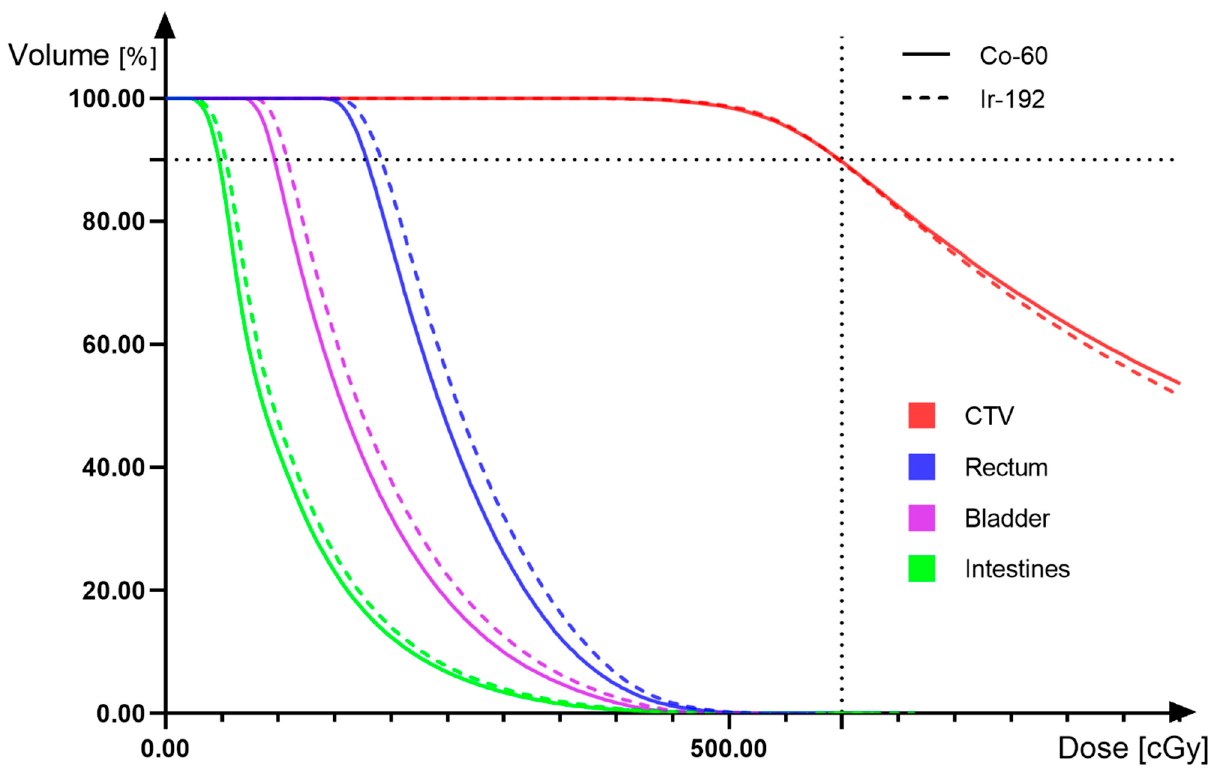
Figure 7. (3D HDR IC-ISBT) Dose-volume histogram comparing 192Ir and 60Co.